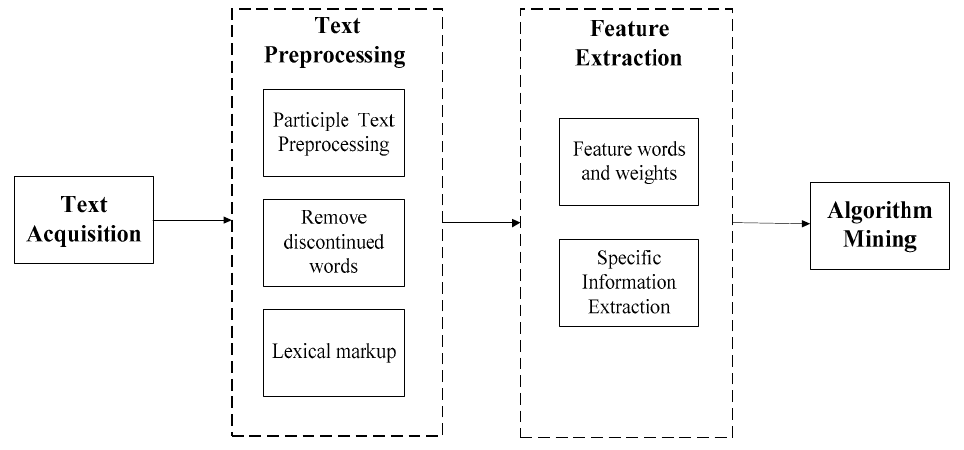
Figure 1. Text mining